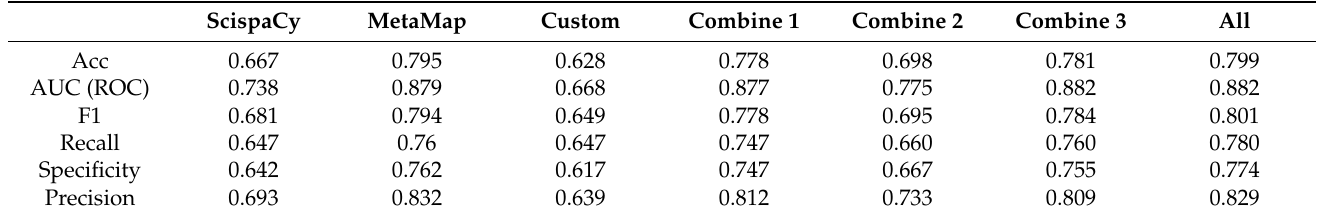
Table 5. Performance of random forest models trained with biomedical information extraction- based features.